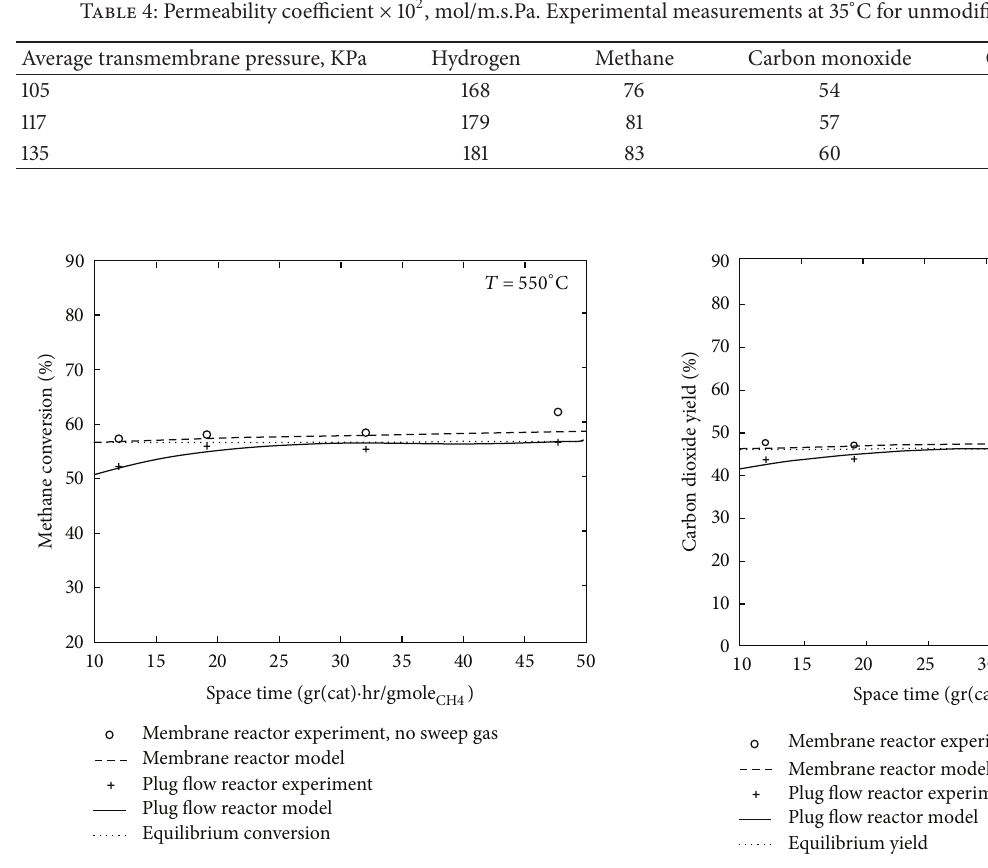
Figure 3: Experimental and modeling results of landfill gas-steam Figure 4: Experimental and modeling results of landfill gas-steam reformers for syngas production and SOFC continuous operation. reformers for syngas production and SOFC continuous operation. = 1.68 atm, feed composition: Total methane conversion data ( 𝑃 𝑇 = 1.68 atm, feed composition: Carbon dioxide yield data ( 𝑃 𝑇 𝑜 𝑜 CH 4 :H 2 O:H 2 = 1:4:0.2. CH 4 :H 2 O:H 2 = 1: